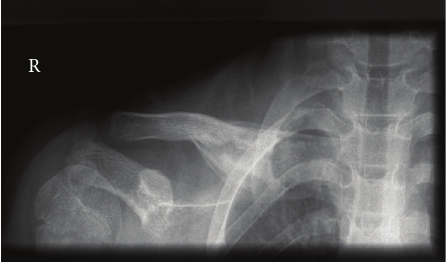
Figure 2: A large mass of the medial clavicle, misread as a callus. It has a moth eaten aspect: typical for osteitis.